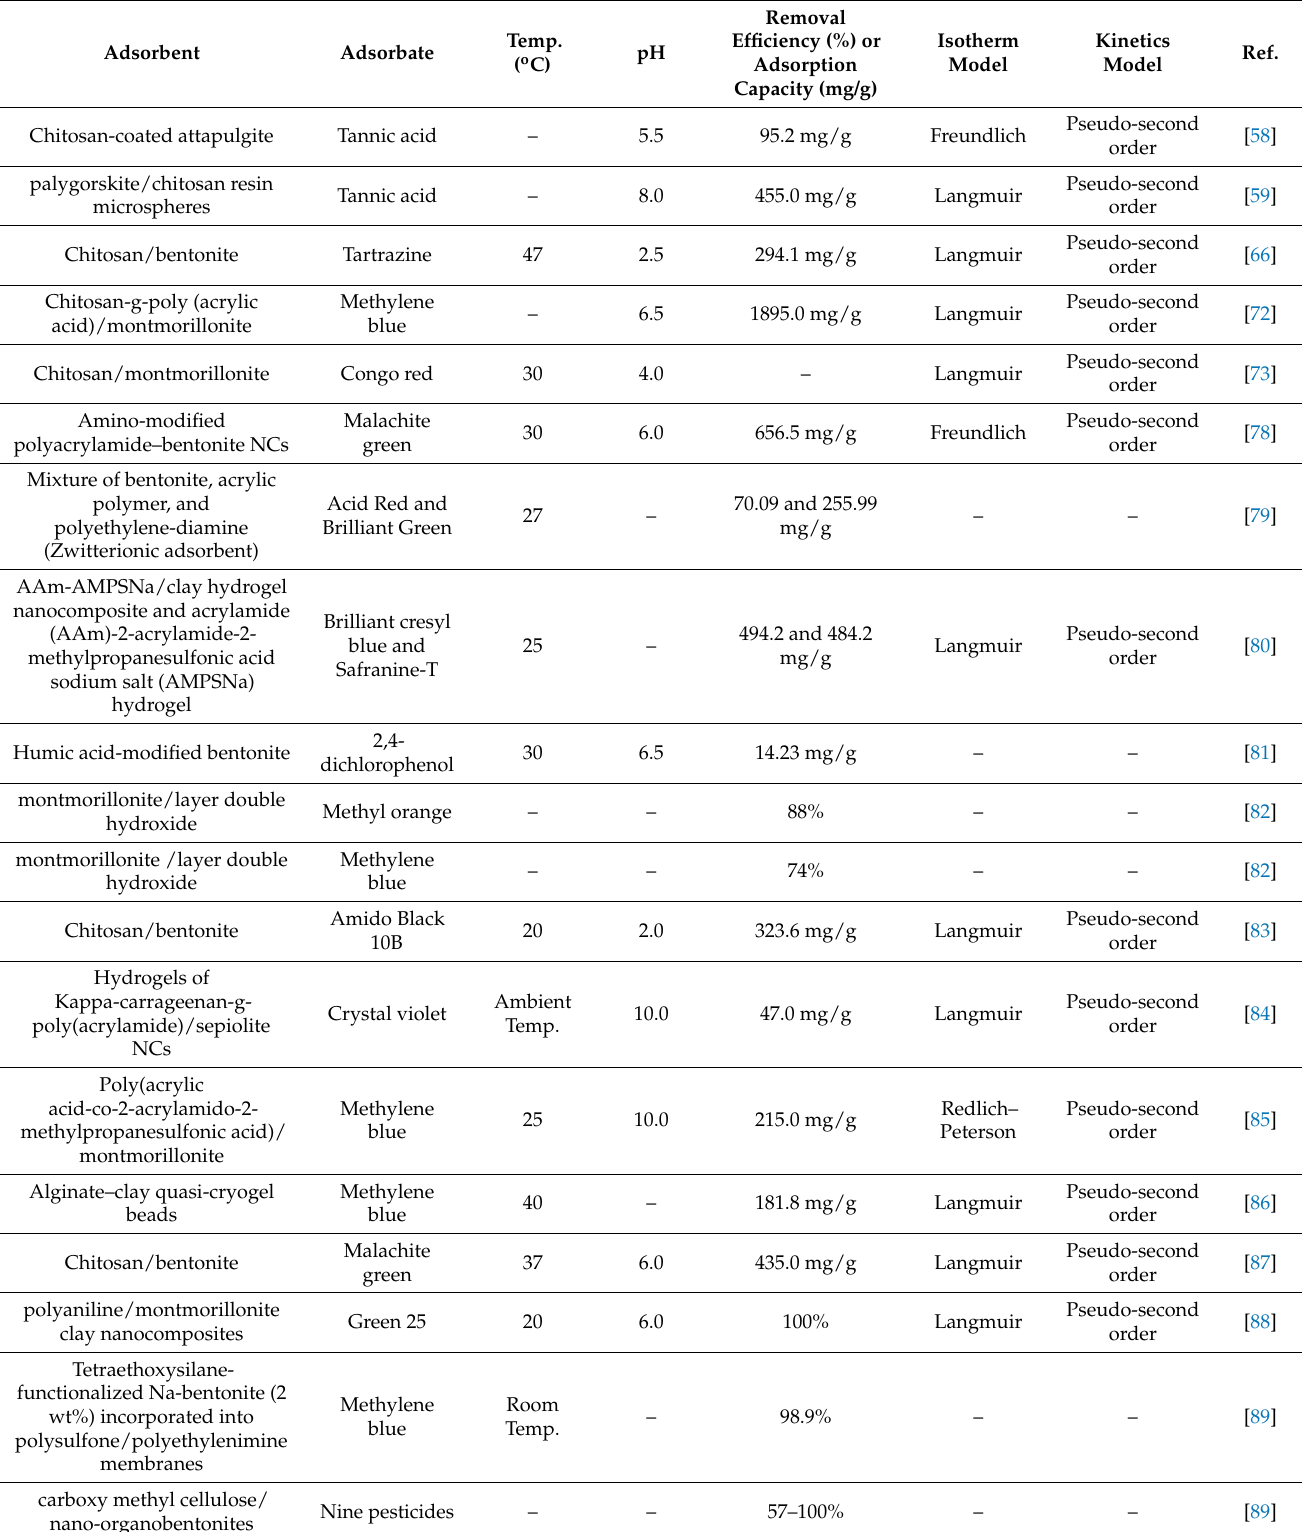
Table 2. Removal of different organic contaminants from water using clay-polymers nanocomposites (CPNs)